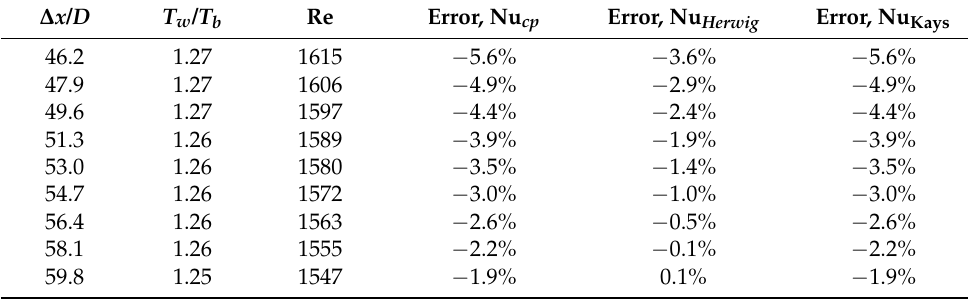
Table 7. Calculation errors of helium by Nu number correlations with case 1.